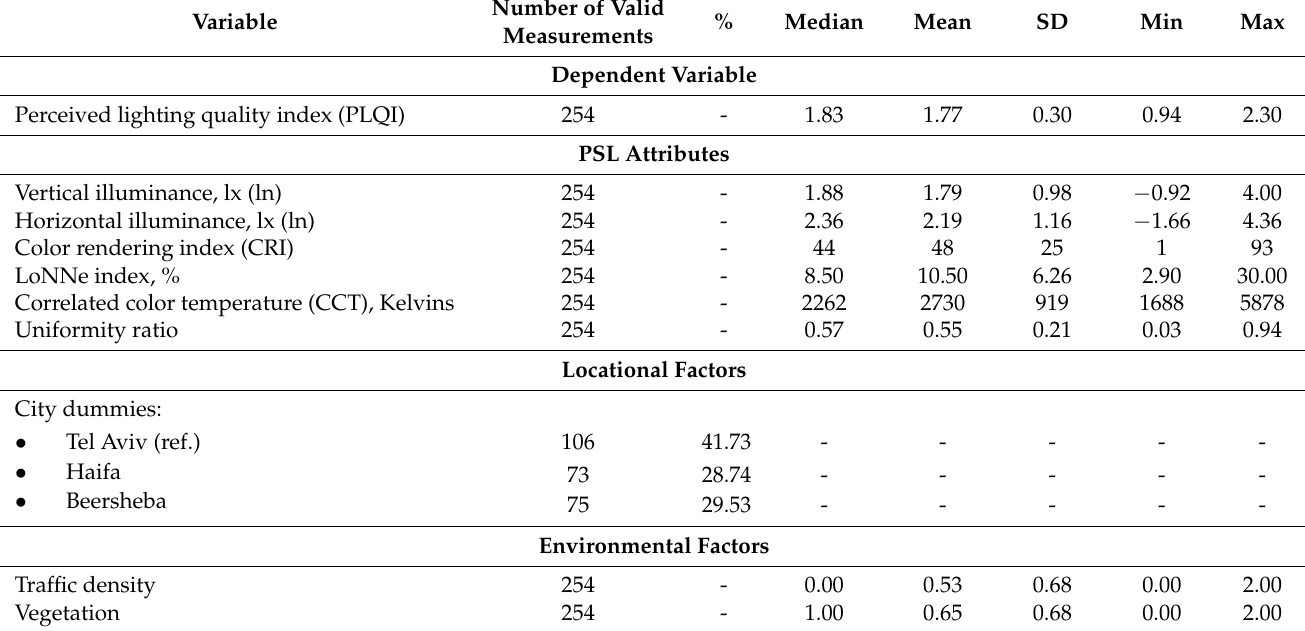
Table 1. Descriptive statistics of the research